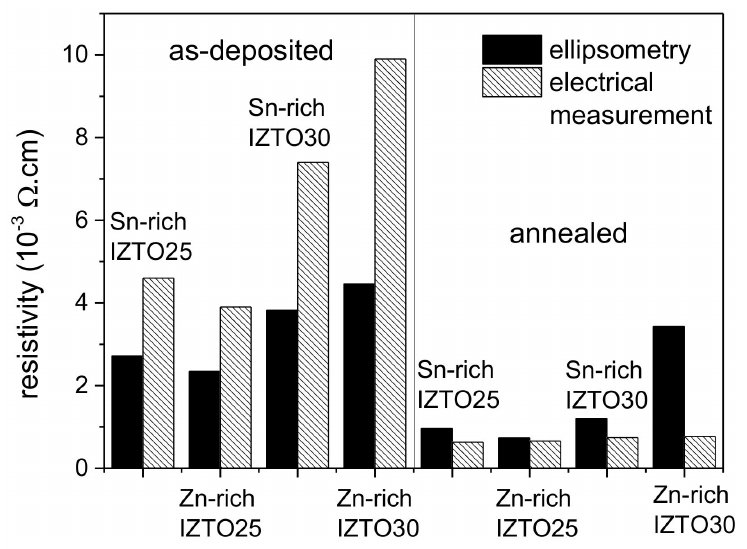
Figure 6. Comparison of specific electrical resistivity determined from near–mid-infrared part of spectroscopic ellipsometry spectra, using Drude oscillator and results from electrical measure- ments. Expected relative experimental error is about 1% in the case of electrical measurements and about 5% in the case of results obtained from ellipsometry measurements. (Sn-rich IZTO25 = In 0.5 Zn 0.20 Sn 0.30 O 1.5 , Zn-rich IZTO25 = In 0.5 Zn 0.30 Sn 0.20 O 1.5 , Sn-rich IZTO30 = In 0.4 Zn 0.25 Sn 0.35 O 1.5 and Zn-rich IZTO30 = In 0.4 Zn 0.35 Sn 0.25 O 1.5